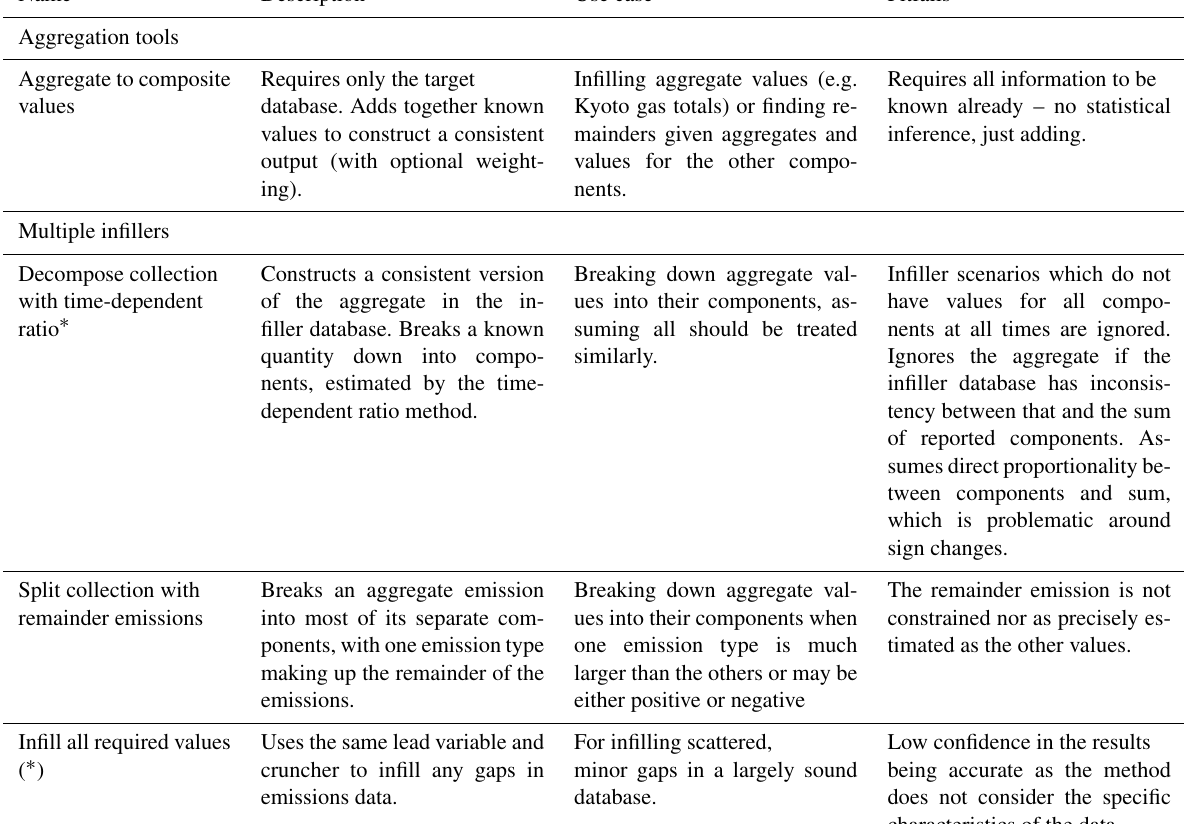
Table 2. Guide to aggregation tools and multiple infillers. Names followed by asterisks use a ratio-based approach; i.e. they find a multi- plicative factor and then multiply the target lead by this value. If the asterisk is in brackets they are